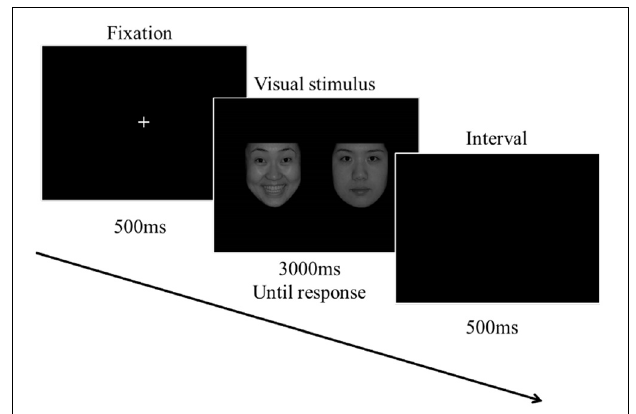
FIGURE 1 | Schematic diagram of the experimental